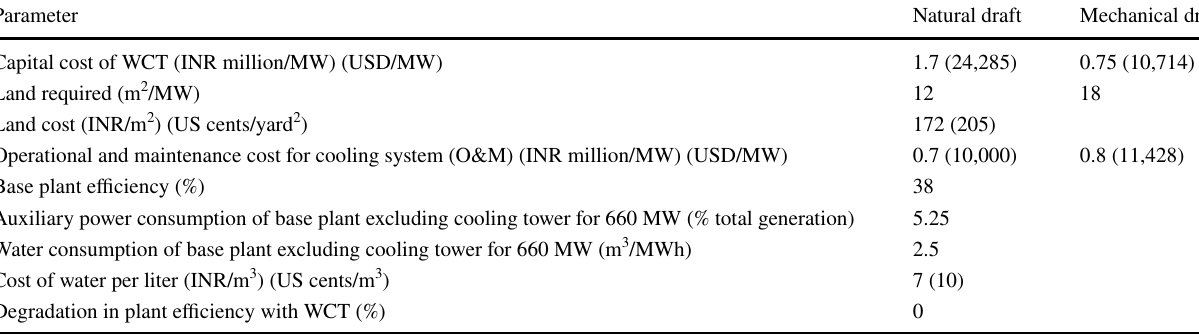
Table 1 Inputs for estimating cost of electricity generation with WCT